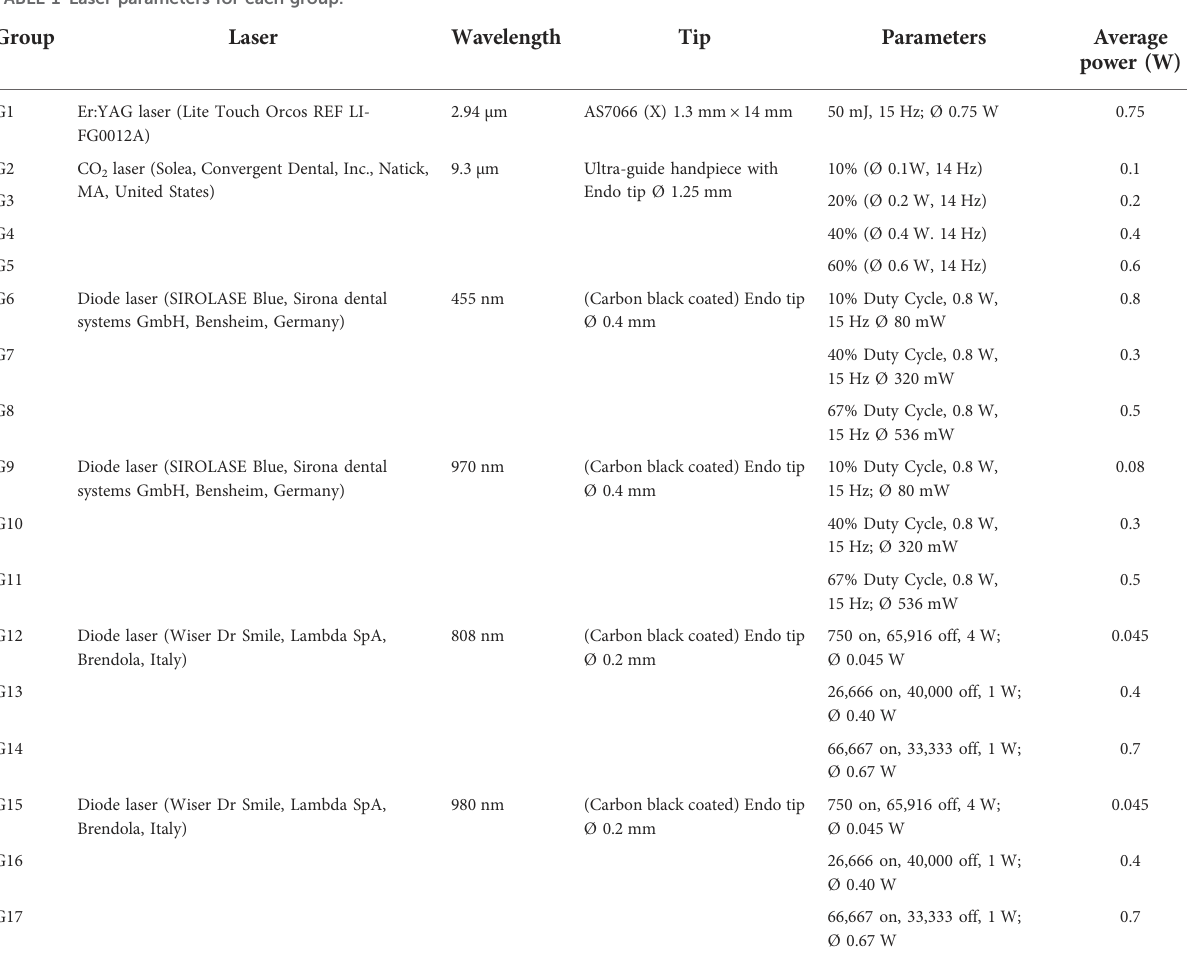
TABLE 1 Laser parameters for each group.